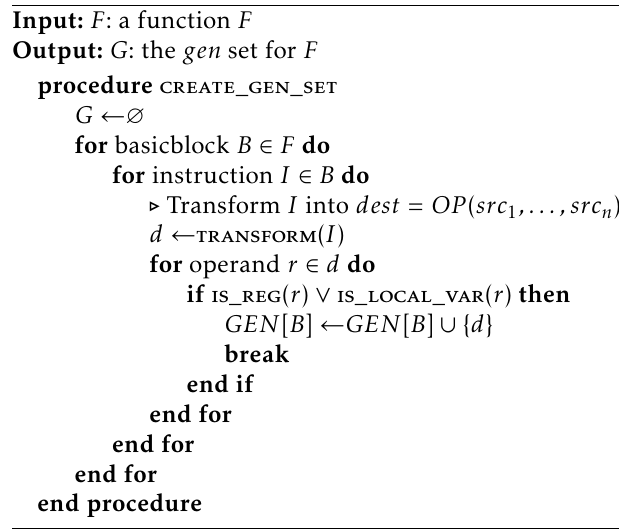
Algorithm 1 Creating the gen set for a function.